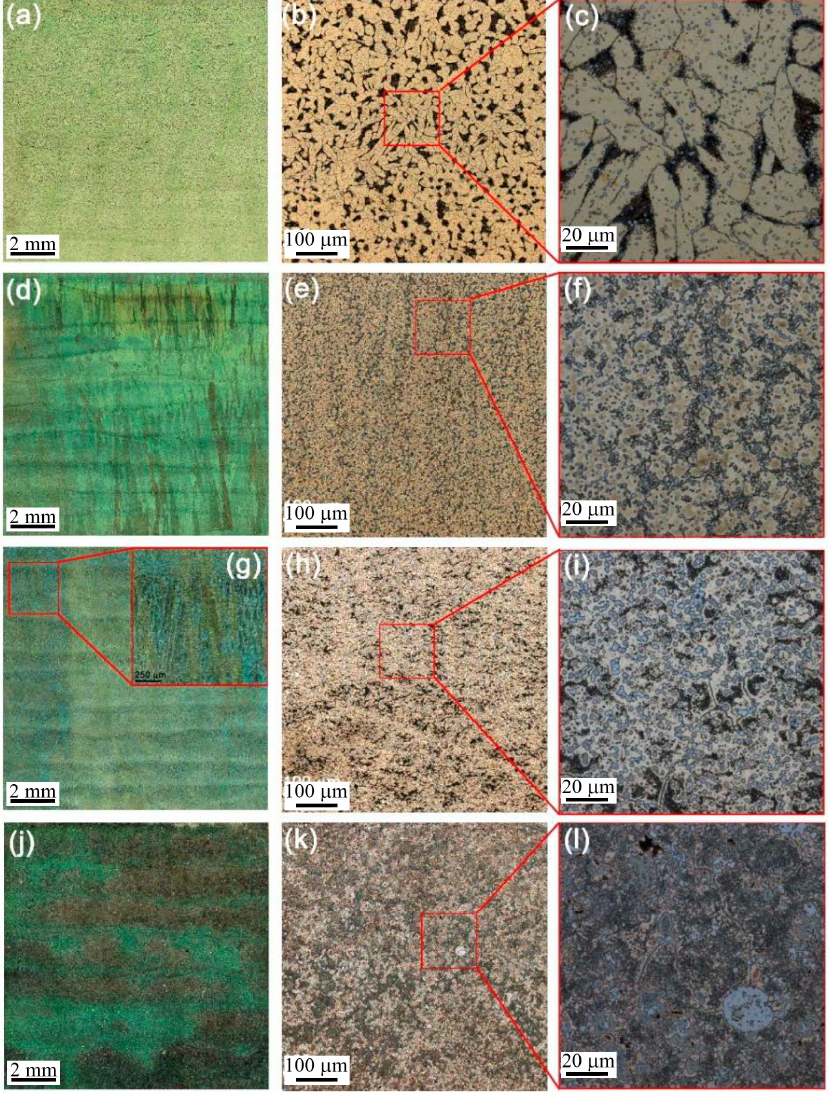
Figure 12. ( a – c ) Microstructures of the 5% Udimet500, ( d – f ) 10% Udimet500, ( g – i ) 15% Udimet500, ( j – l ) 25% Udimet500 alloys [133].